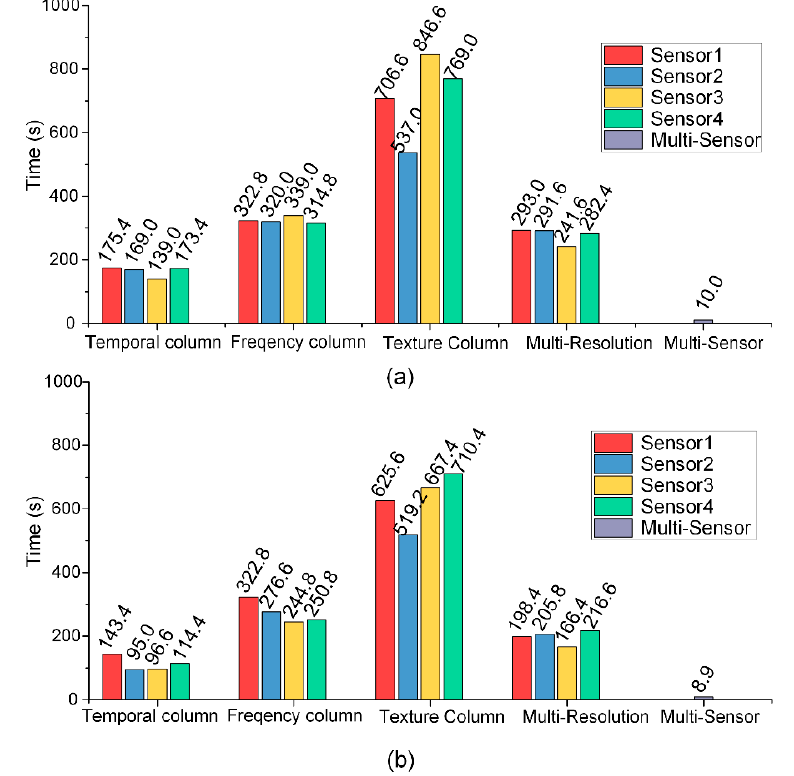
Figure 14. Time consumptions of the three stages of the transfer learning: ( a ) The defect types and positions; ( b ) the defect types only.